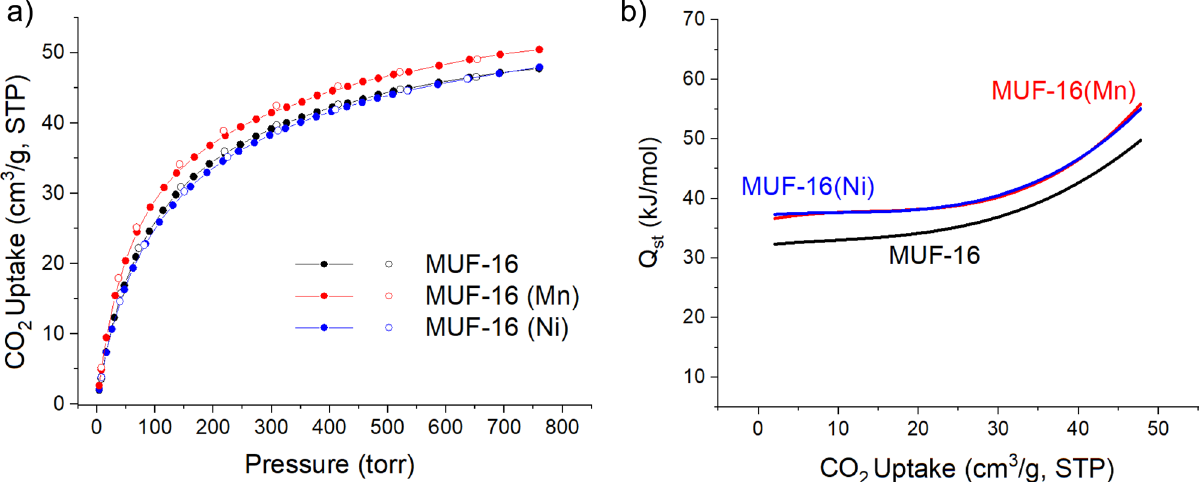
Fig. 2 CO 2 adsorption on MUF-16 materials. a Volumetric adsorption ( fi lled circles) and desorption (open circles) isotherms of CO 2 at 293 K and for MUF- 16 (black), MUF-16(Mn) (red), and MUF-16(Ni) (blue). b Heats of adsorption ( Q st ) calculated for CO 2 binding to MUF-16 (black), MUF-16(Mn) (red), and MUF-16(Ni) (blue) as a function of CO 2 uptake. A high af fi nity for CO 2 coupled to a moderate heat of adsorption promise an adsorbent that takes up signi fi cant quantities of gas yet is easily recycled. Source data are provided as a Source Data fi